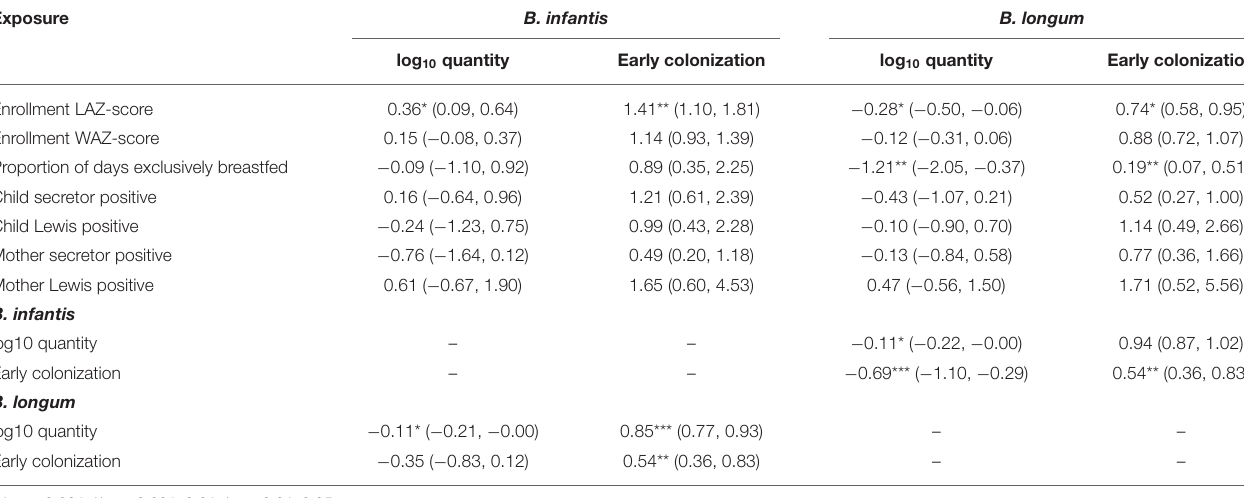
TABLE 2 | Coefficient estimates (with 95% confidence intervals) from regression models of the associations between seven time-fixed, early-life exposures and indicators of quantity (linear regression) and early colonization (logistic regression) for two Bifidobacterium longum subspecies, adjusted for site, socio-economic status (WAMI score) and sex.